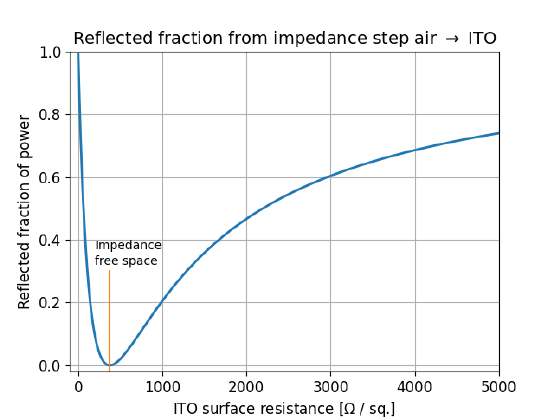
Figure 10. Reflection due to impedance step air →